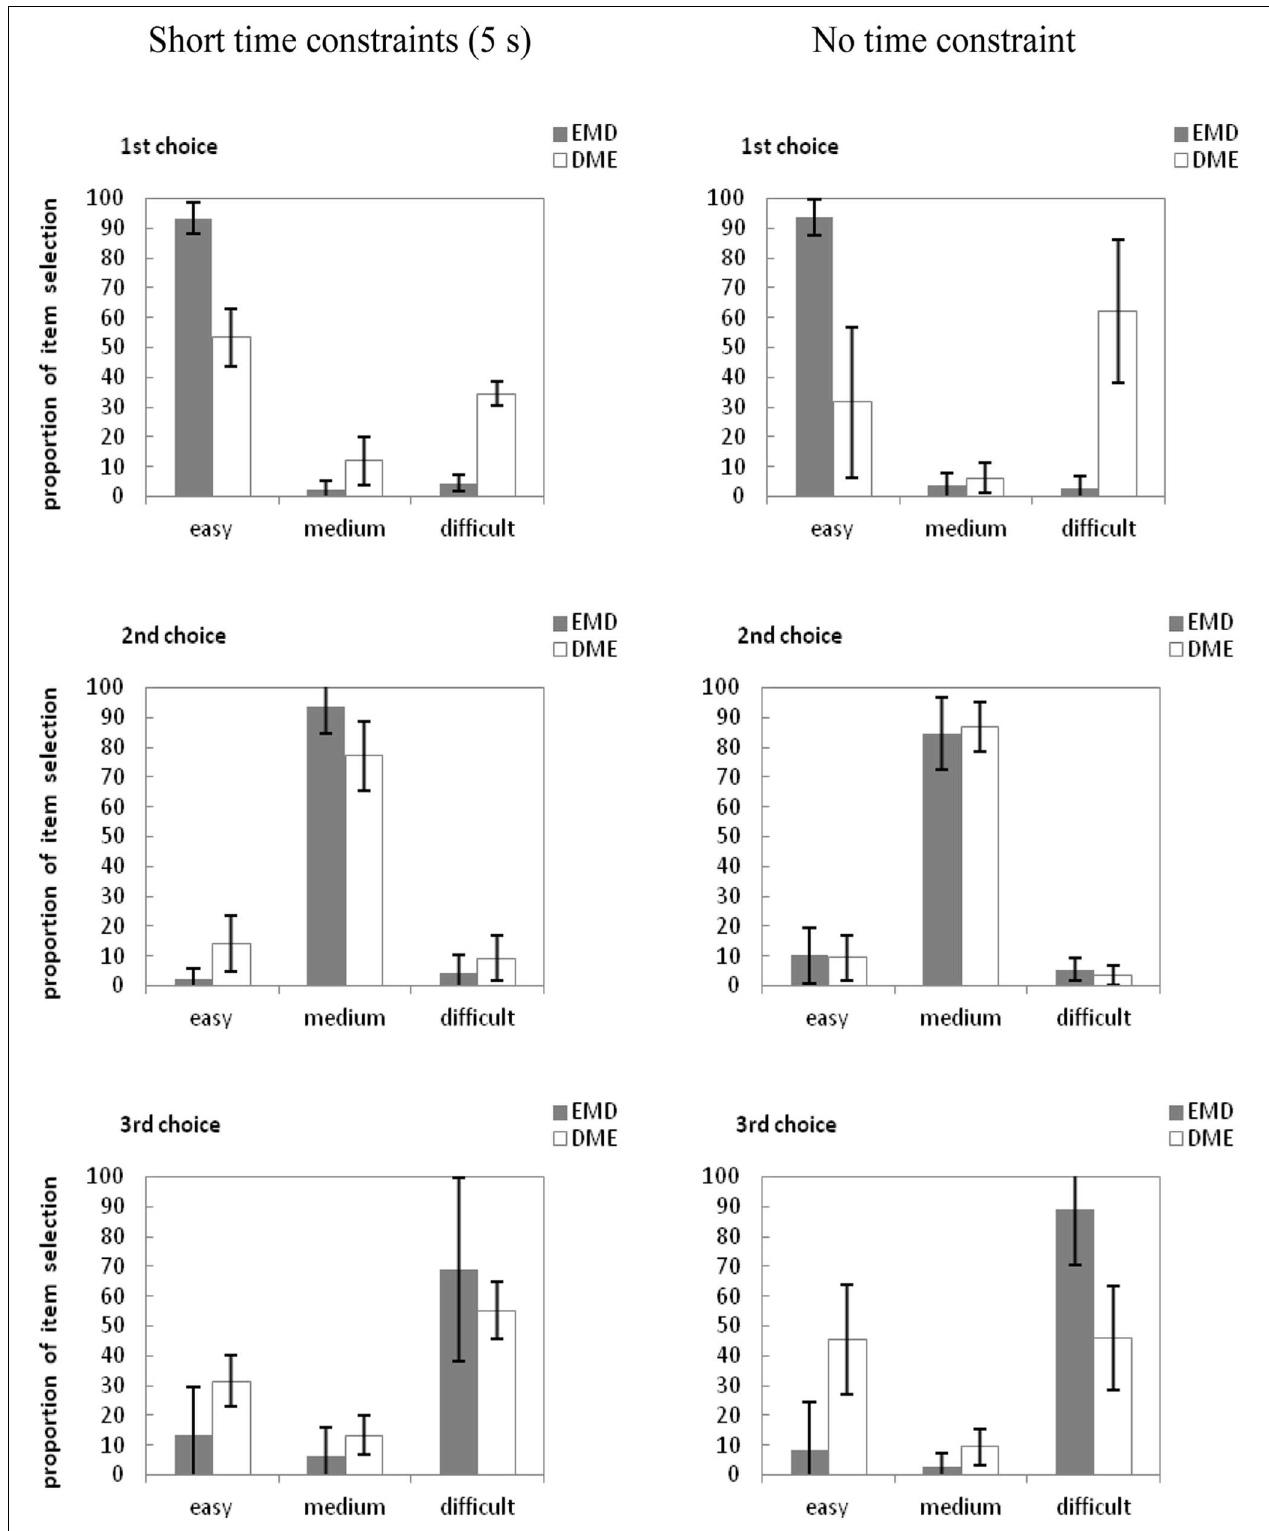
FIGURE 3 | Mean proportion of items selected for the first, second, and third choice across the word pair arrays in Experiment 3a. E, easy word pair; M, moderately difficult word pair; D, difficult word pair. Error bars are standard errors of each mean.